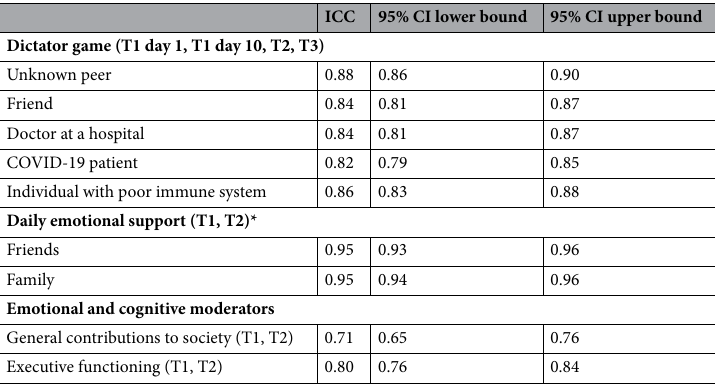
Table 5. Intraclass correlation coefficients (ICC) across all timepoints (T1, T2, and T3). *ICC of daily emotional support based on 10 daily measures at each timepoint (T1 and